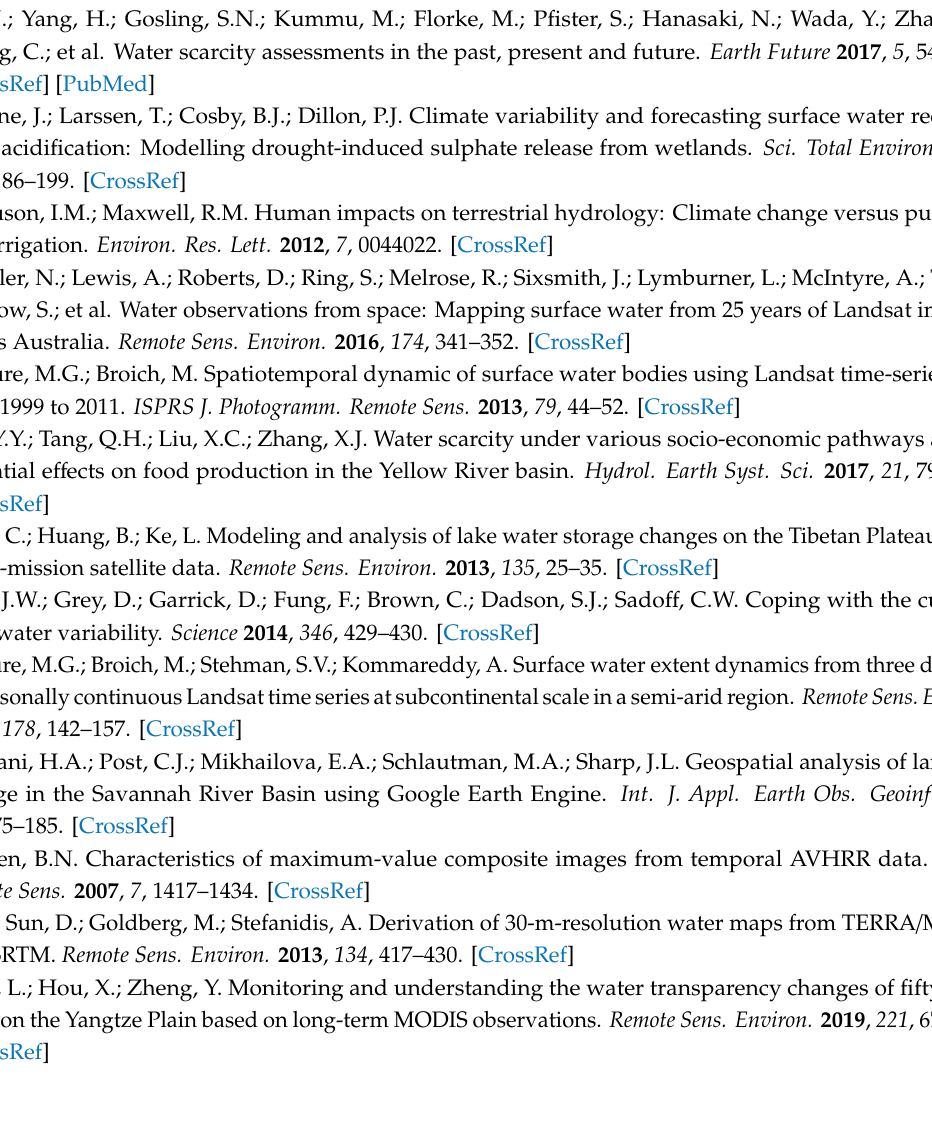
Figure S1: The slope value in the Hetao Plain. Figure S2: The time series of the permanent water body area and annual cumulative precipitation in the Hetao Plain from 1989 to 2019. Figure S3: The trend of sown area in the Hetao Plain from 1989 to 2018. Figure S4: The trend of population and GDP in the Hetao Plain from 1989 to 2018. Figure S5: Changes in the land-use area in the Hetao Plain from 1990 to 2015. Figure S6: The ratio of irrigated area to the sown area in the Hetao Plain from 1989 to 2018. Table S1: The trend and correlation in the permanent water body area and precipitation in the Hetao